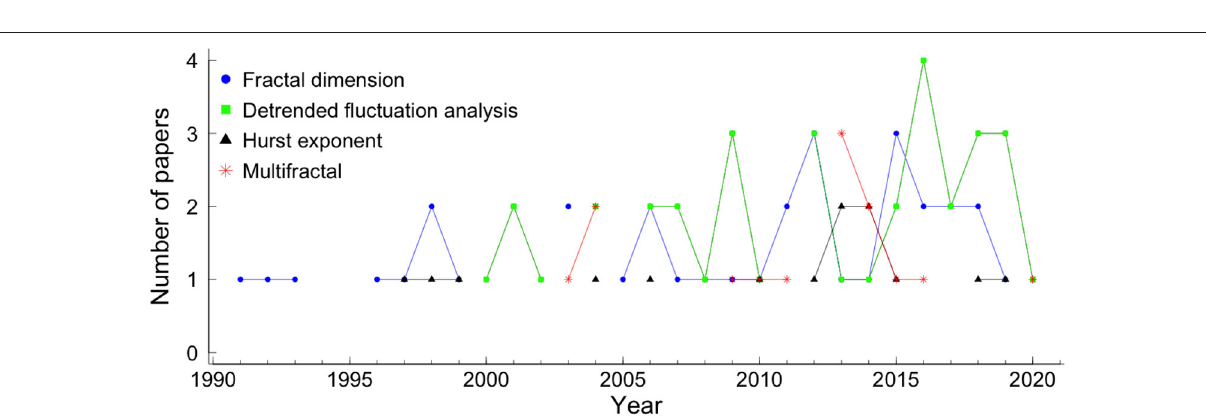
FIGURE 5 | Papers using fractal analysis in fetal heart rate, by year. The blue circle represents the fractal dimension measure, the green square represents the detrended fluctuation analysis, the black triangle represents the Hurst exponent, the red star represents the multifractal